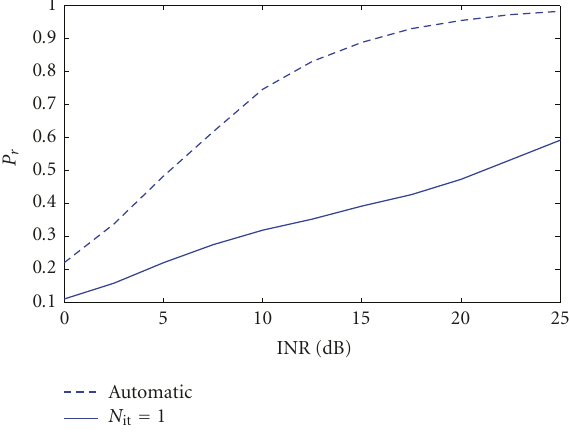
Figure 14: P r versus INR. Data from file 19980204 − 220849, with = 0 . 025, and ni = N = 8, K = 24, P e 0